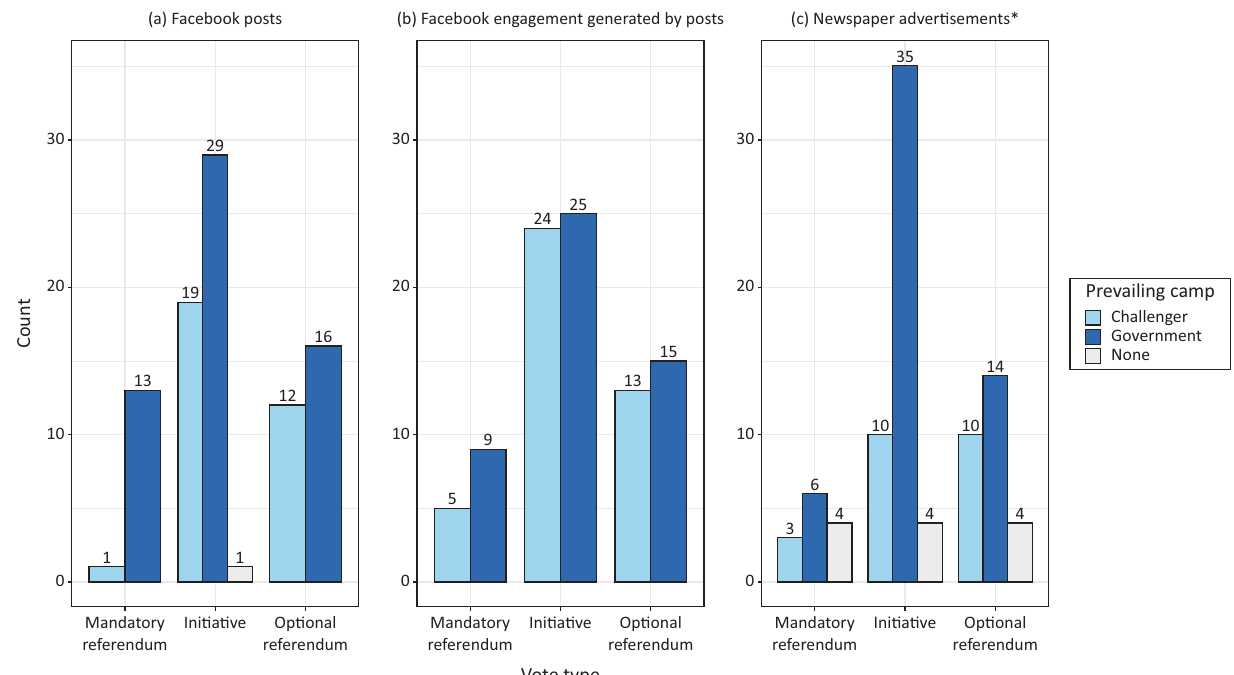
Figure 3. Number of direct democratic votes in which the government camp or the challenger camp prevailed in terms of Facebook activity, Facebook engagement generated by the posts, and offline campaign activity. Note: * = Removed one mandatory referendum (“additional financing of the old‐age pension through an increase in value‐added tax”) due to missing